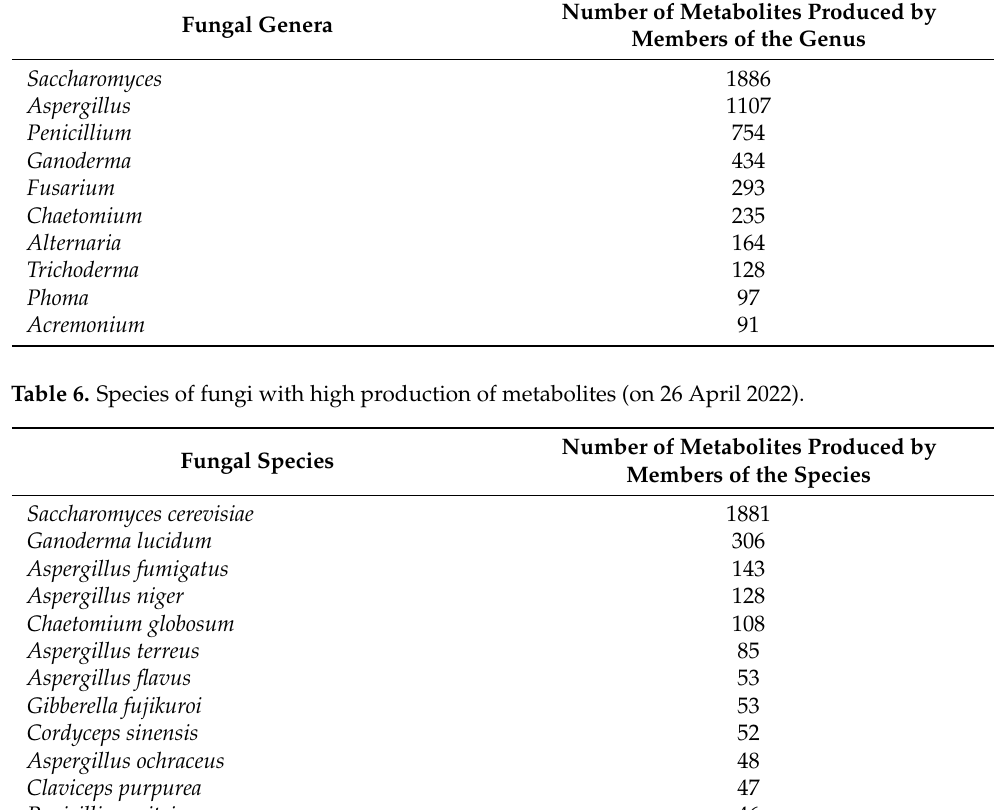
Table 5. Genera of fungi with high production of metabolites (on 26 April 2022). Fungal Genera